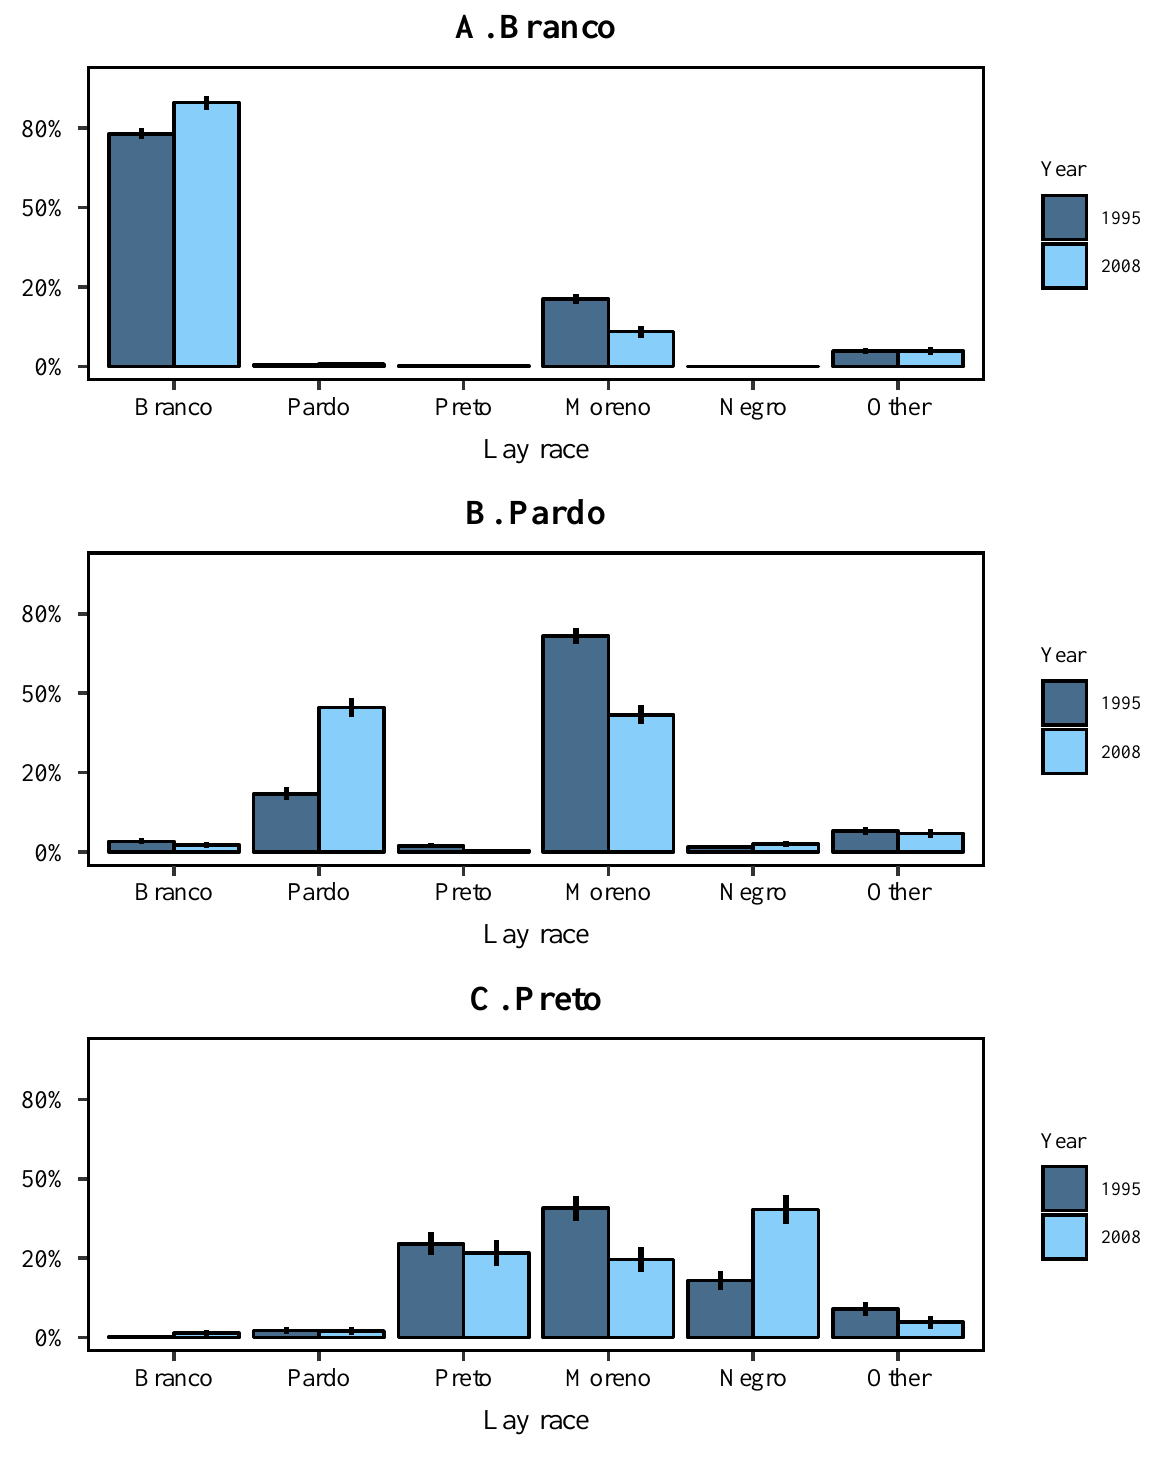
Figure 3: Government classification by lay identification, 1995 and